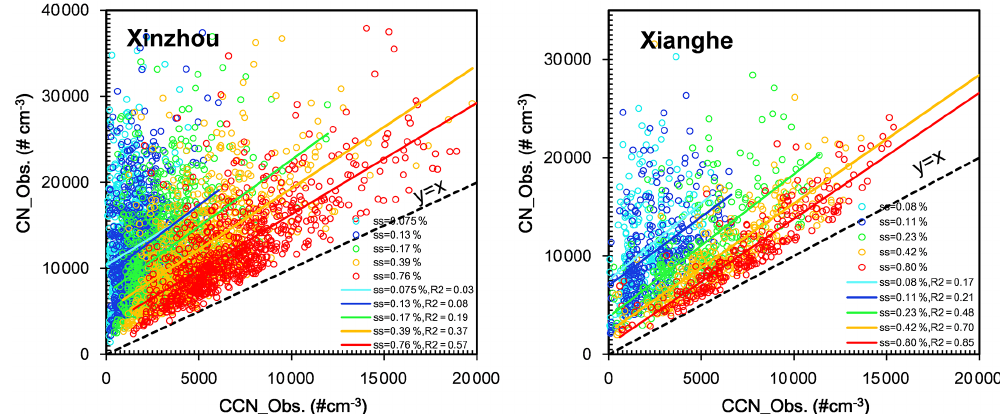
Figure 4. Measured N CN as a function of measured N CCN for different supersaturation levels at the Xinzhou (left panel) and Xianghe (right panel) sites. The scatter plot between CCN_Obs and CN_Obs were fitted with a linear function (in colored lines) and R 2 refer to the correlations of